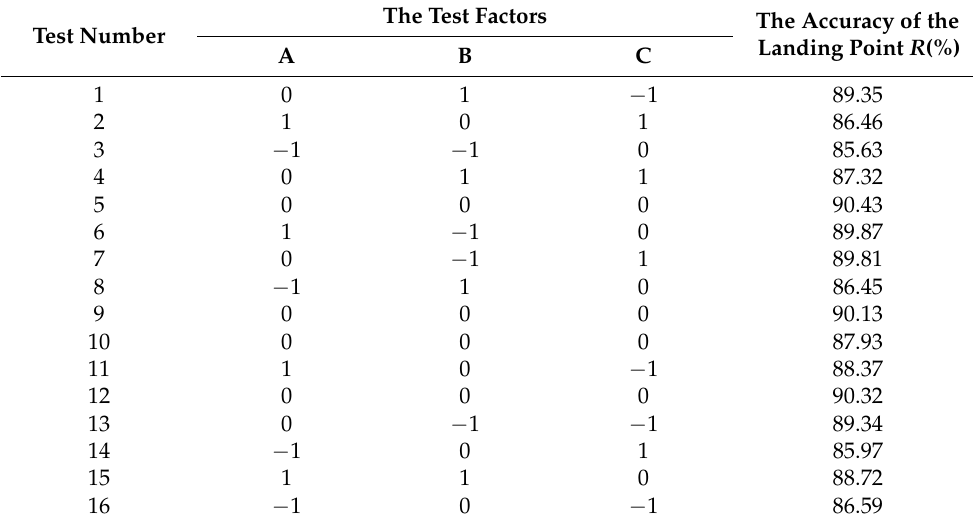
Table 2. Experimental design and